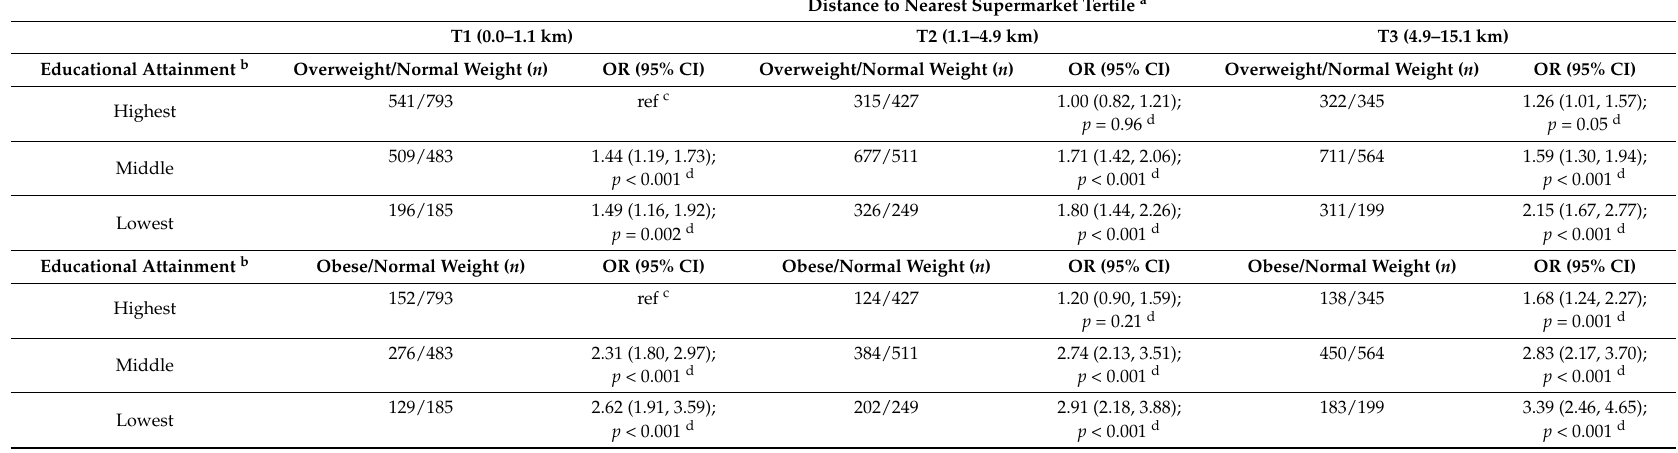
Table 3. Additive interaction between supermarket distance and educational attainment on the likelihood of being overweight or obese, modelled using a single multinomial logistic regression model in the Fenland Study sample ( n =